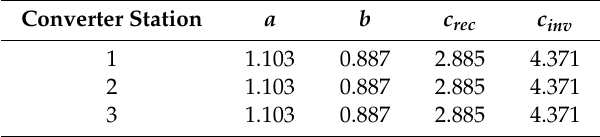
Table 4. Power losses coe ffi cients of the converter stations.